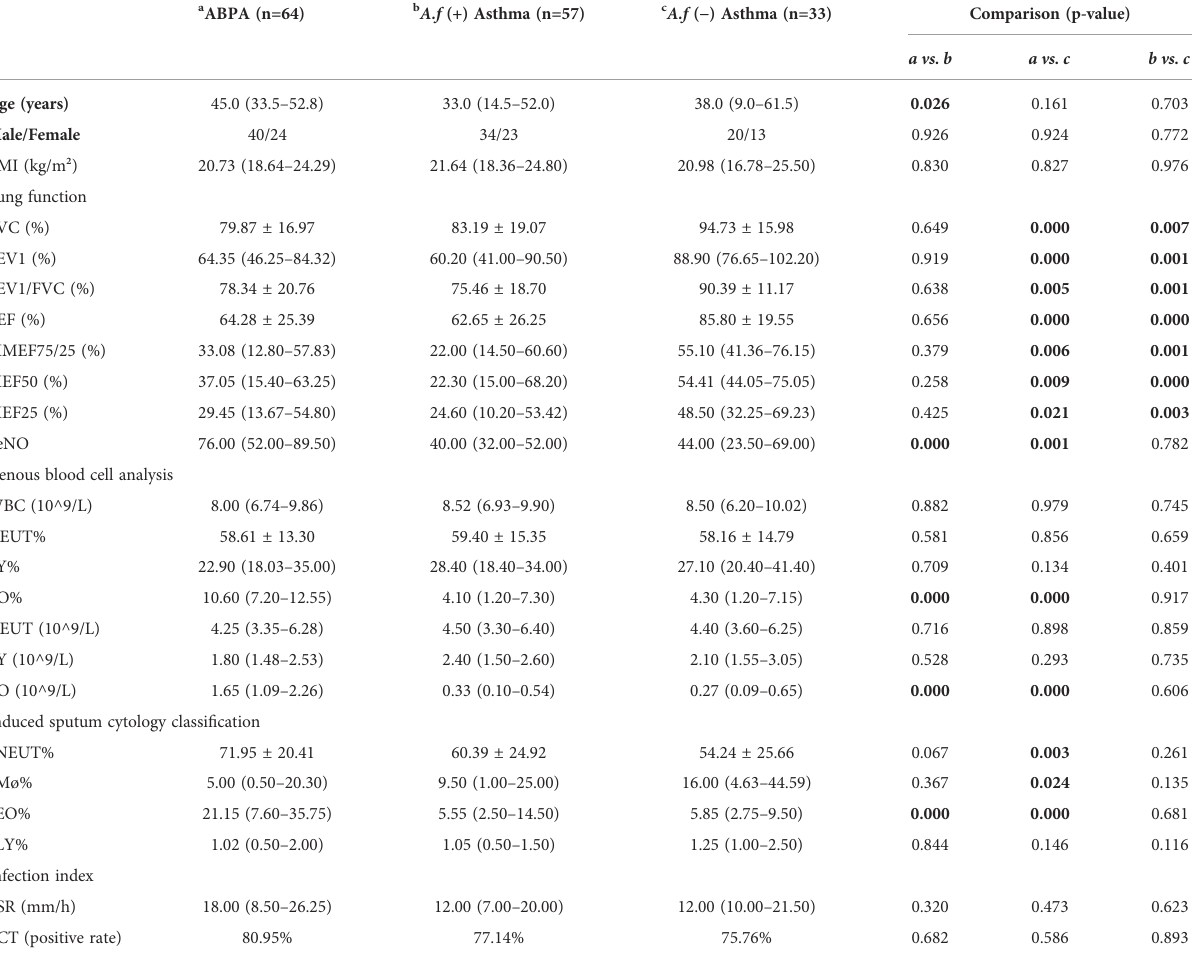
TABLE 1 The comparison of clinical parameters in the three